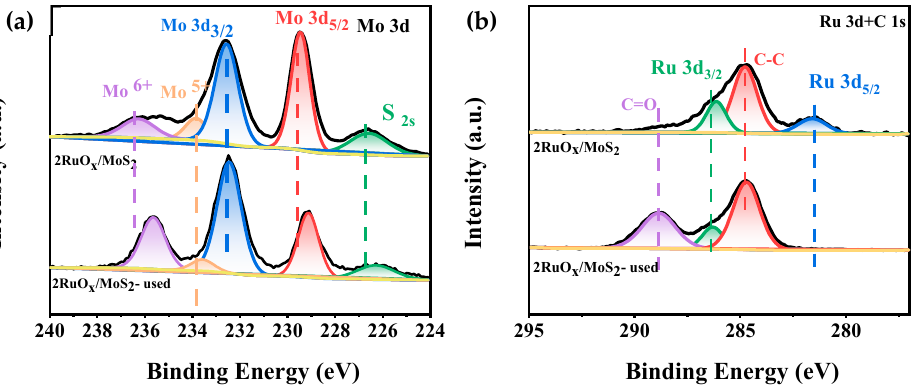
Figure 5. XPS spectra of the fresh and used 2RuO x /MoS 2 catalyst ( a ) Mo 3d, ( b ) Ru 3d and C1s.